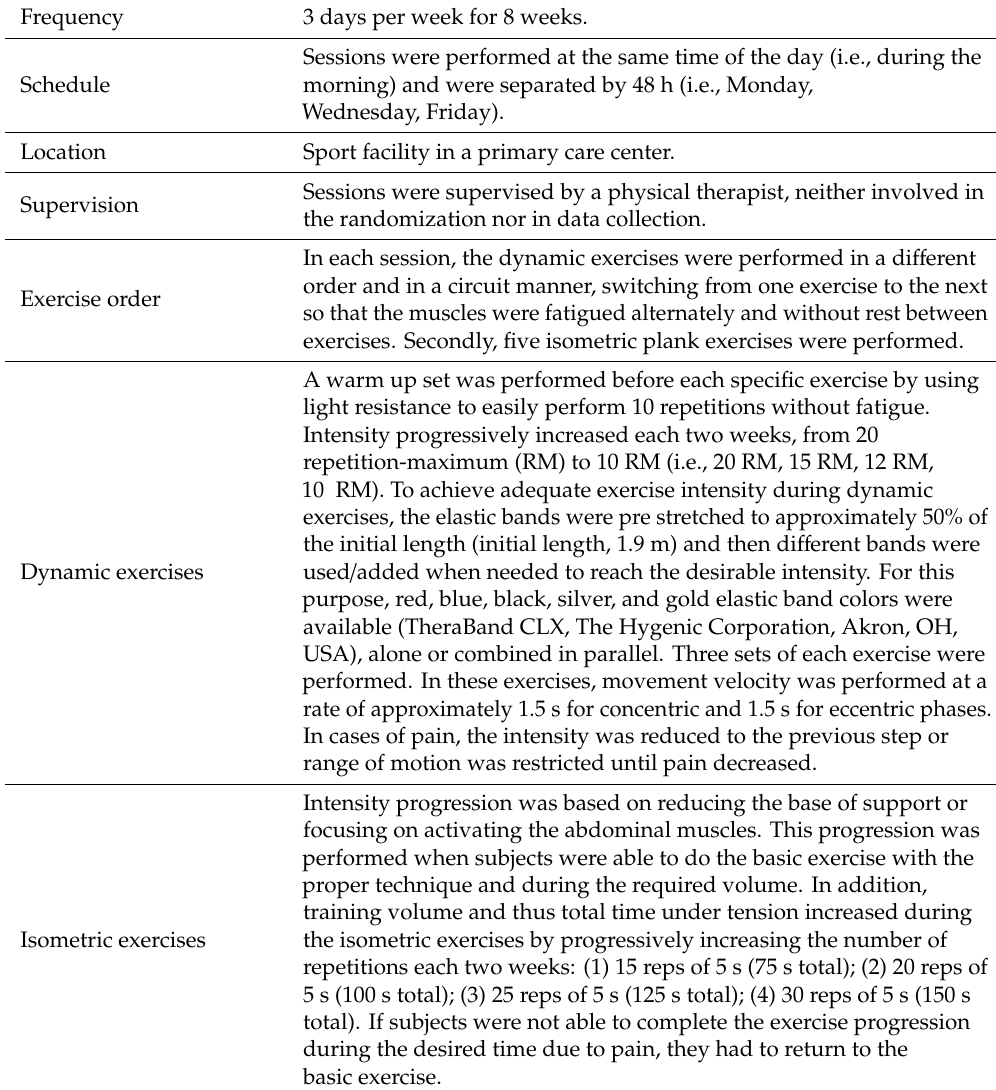
Table 1. Exercise